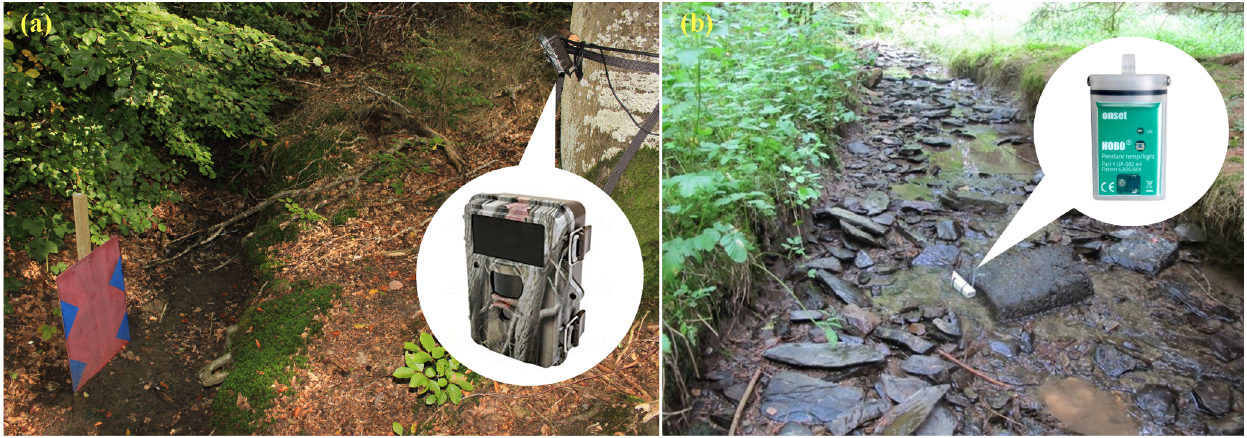
Figure 3. Sensor setup for time-lapse camera (a) and EC sensor (b) . The EC sensor housing is mounted to a concrete block in the streambed.